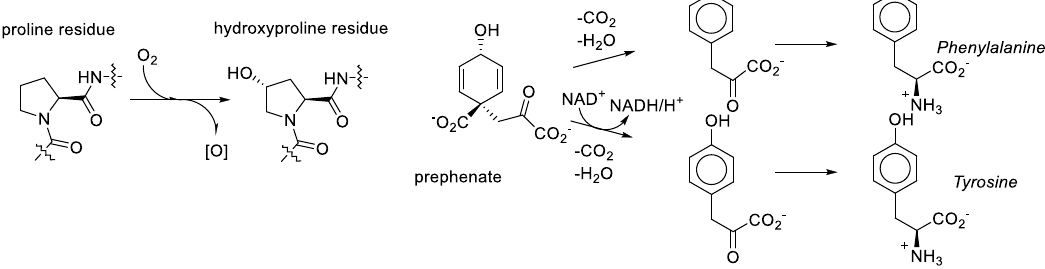
Figure 10. The oxidant requirements towards hydroxyproline and tyrosine are di ff